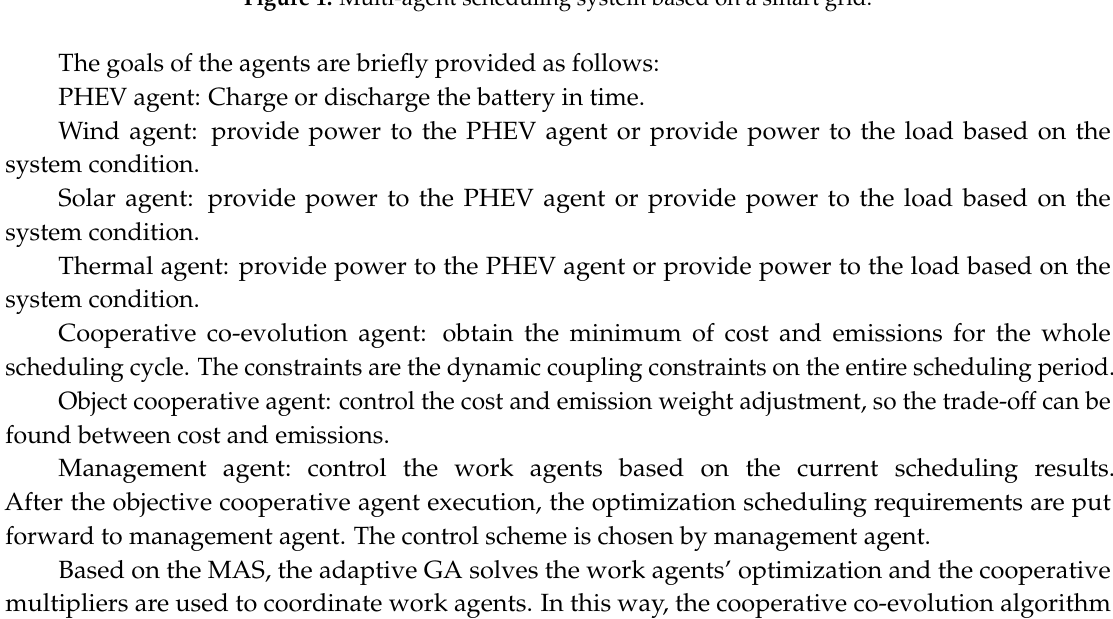
Figure 1. Multi-agent scheduling system based on a smart grid.